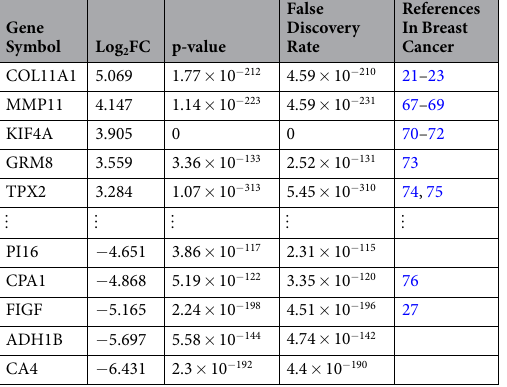
Table 3. Top and bottom five differentially expressed genes. Linear model raw p-values results were corrected for multiple comparisons using the False Discovery Rate method. Gene expression differences between cancerous and healthy samples are presented in log 2 scale ( log 2 FC ).